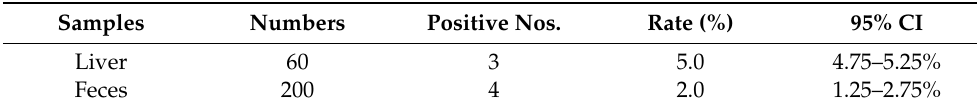
Table 1. Detection of HEV RNA of sheep in Töv Province.